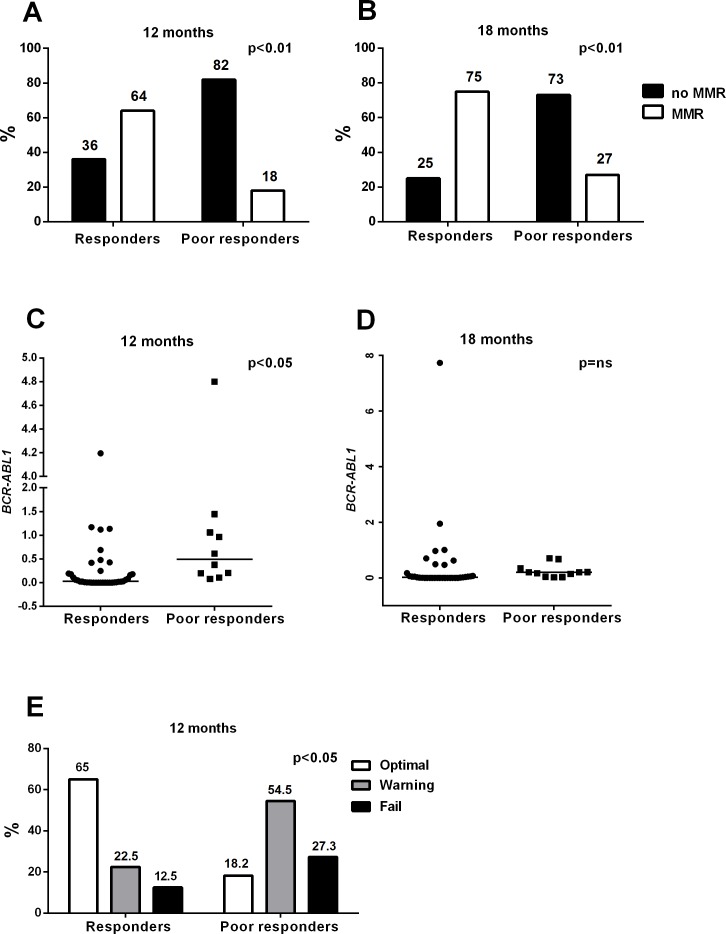
Poor responders have an inferior outcome at 12 and 18 months.A-B) The poor responders achieved MMR more seldom at 12 months (p<0.01) and 18 months (p<0.01) compared to responders. C–D)
Poor responders had a higher BCR-ABL1 transcript level at 12 months compared to the responders (p<0.05), whereas no difference was observed at 18 months. E) According to the ELN 12-month classification, the poor responders were significantly more often classified as warning and failures than the responders (p<0.05). In panels A, B, and E, statistical significance was analyzed with a chi-square test. In C and D, an unpaired two-tailed t-test was applied, and median values are noted with lines.